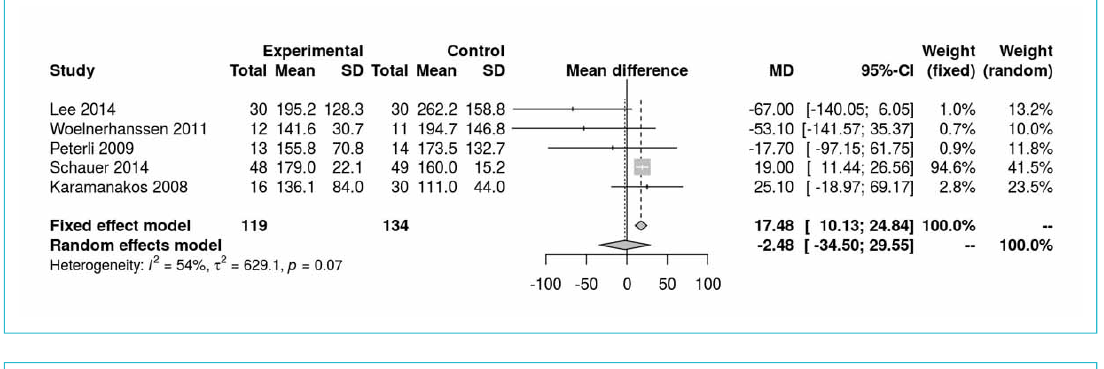
Figure S5b: Triglycerides at baseline without Schauer et al. 2014 [13].